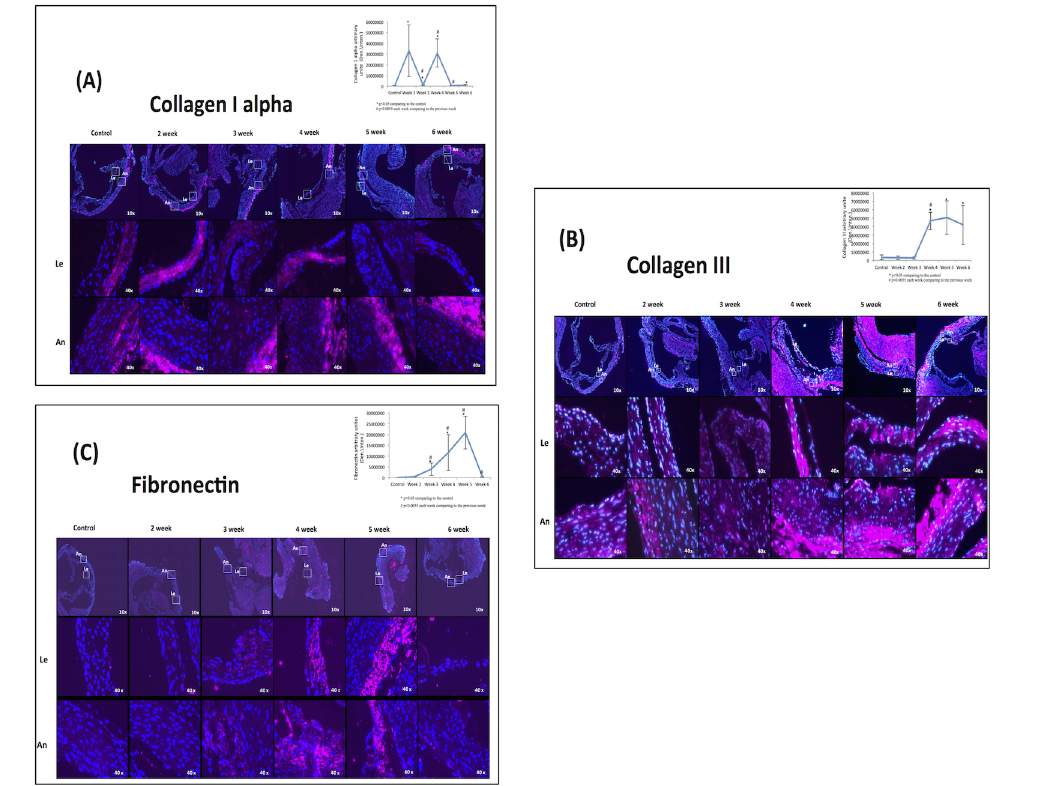
Fig 3. ECM expressions. Aortic valve sections, including the annulus (An) and a leaflet (Le), from study groups before and after immunohistochemical staining. (A) Collagen 1 staining. (B) Staining of collagen 3. (C) Staining of